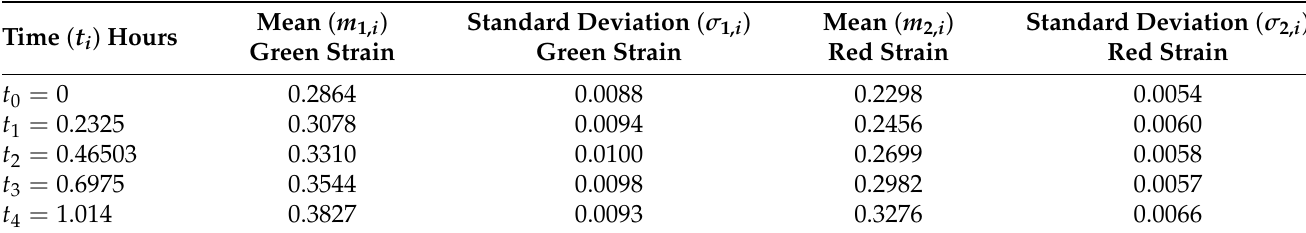
Table 1. Mean and variance of the optical densities (OD) at different time instants of the two E. coli strains in mono-culture growth [28] (Experiment B).